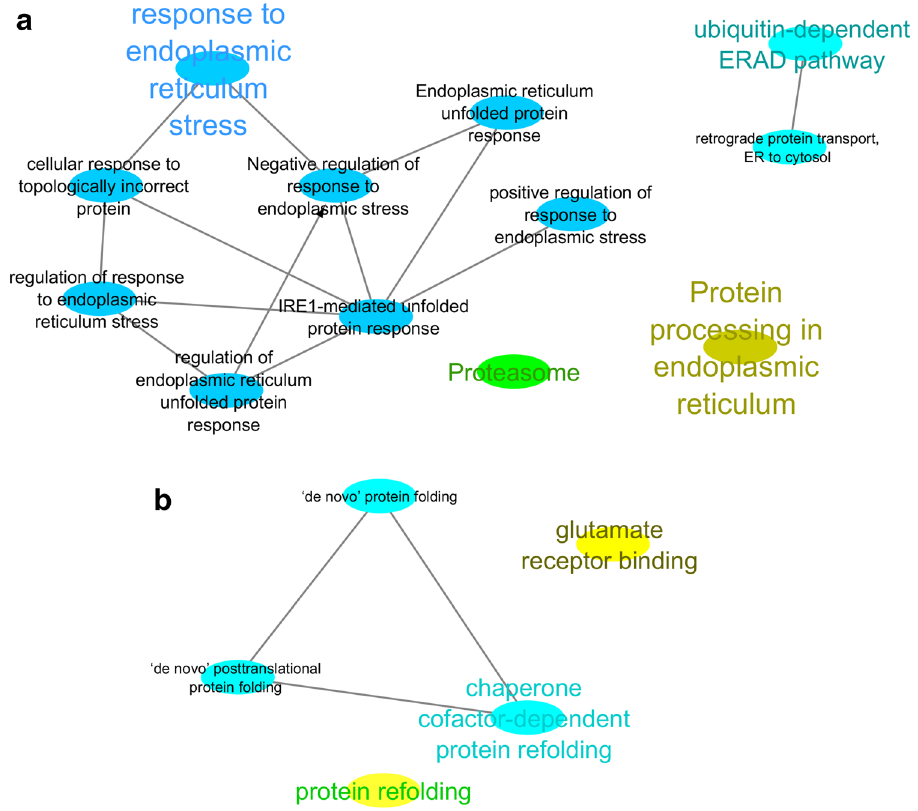
Figure 1. Network visualization of enriched pathways (GO/KEGG) 24 in the gene signature was performed by ClueGO analysis. ( A ) BP vs. P and ( B ) P vs.